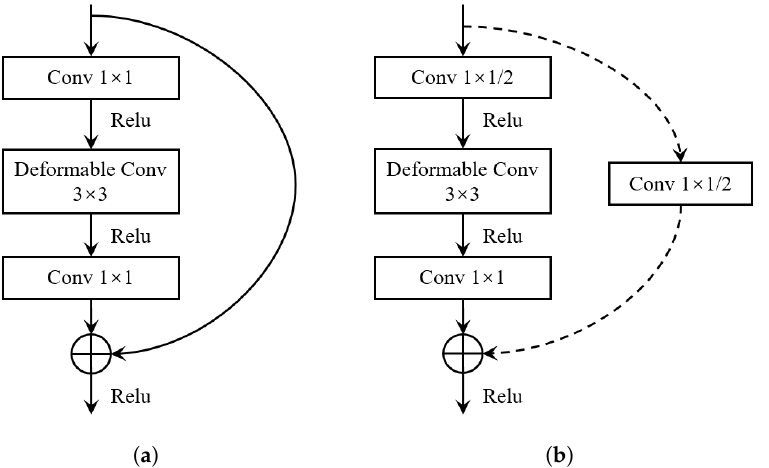
Figure 9. Two residual blocks (three layers) with deformable convolutions. ( a ) The bottleneck layer that makes the shape of the feature map invariant; ( b ) the bottleneck layer that reduces the length and width of the feature map to